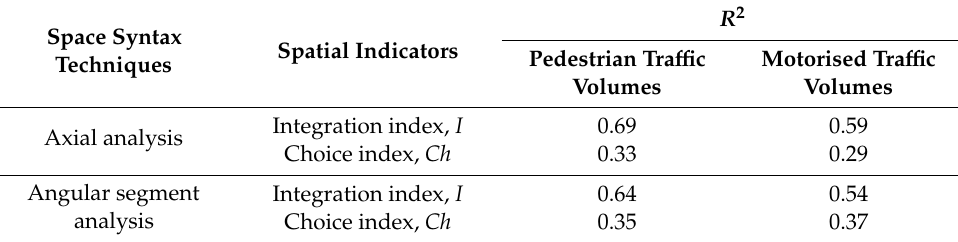
Figure 7. Correlations between the logarithm of the observed traffic volumes for the 40 roads and the four analysed spatial indicators ( I and Ch for the axial analysis; I and Ch for the angular segment analysis). Table 3. Comparison of the R 2 coefficients obtained from the correlations between the pedestrian and motorised traffic volumes and the spatial indicators.